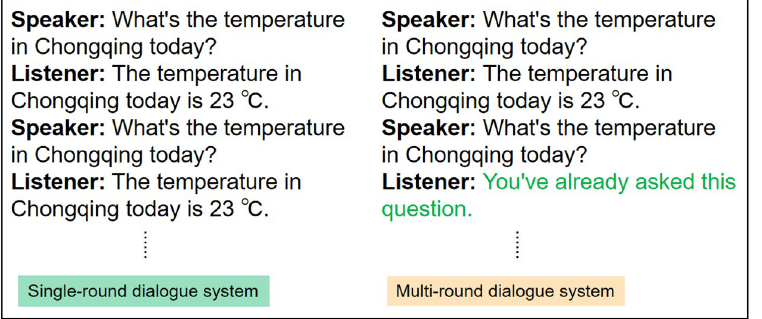
Fig 2. Representation of single-round dialogue and multi-round dialogue